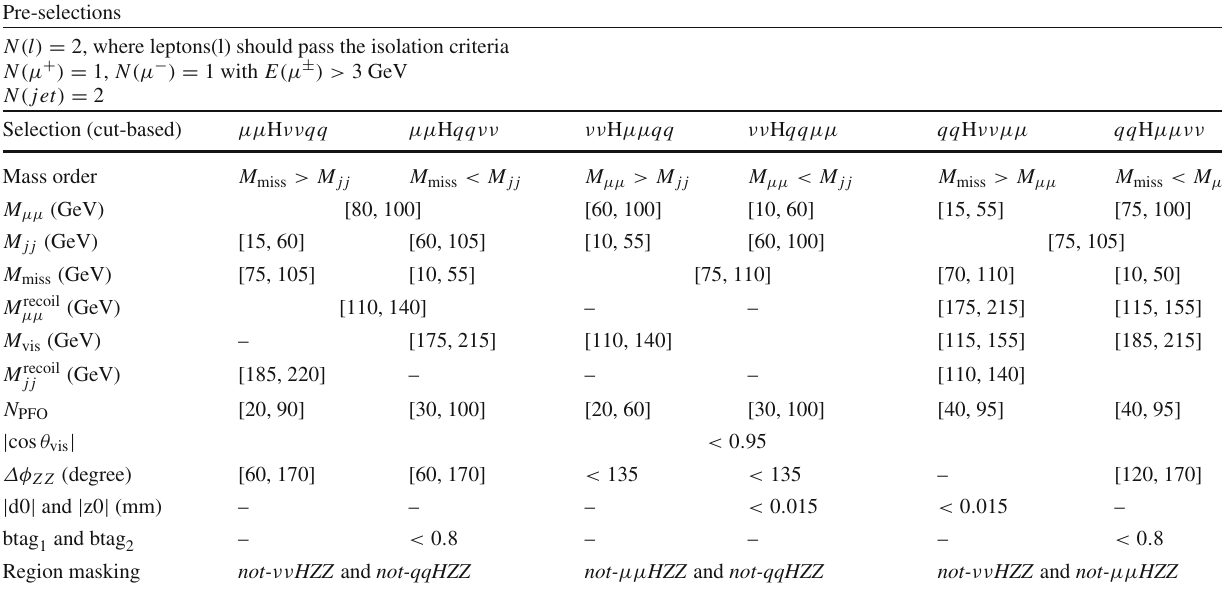
Table 1 Overview of the requirements applied when selecting events (cut-based)